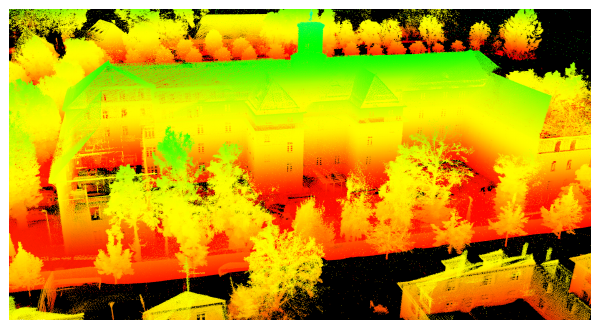
Figure 4. Plotted accumulated 3D data after reduction to a voxel grid (for visualization).